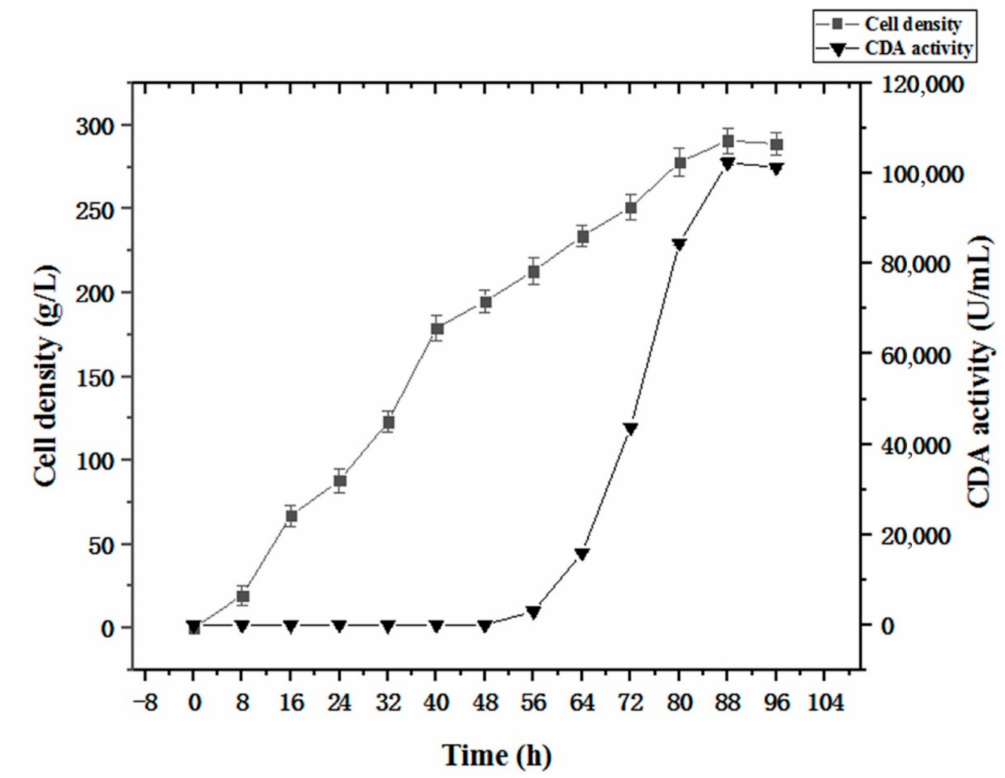
Figure 10. Time course of displayed CDA fermentations based on a fermentation strategy described in the Section